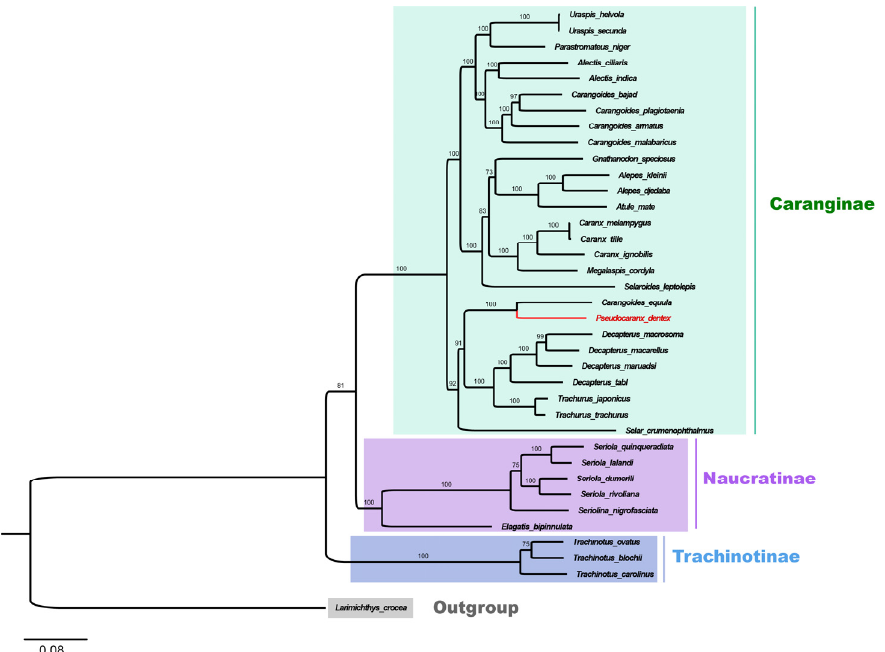
Figure 5. Phylogenetic tree of 36 species from the Carangidae family constructed by the maximum Likelihood method based on the concatenated sequences of 13 PCGs. L. crocea was set as an outgroup. The bootstrap support values were displayed on the branches. The species in red ( P. dentex ) was generated in the present study. Trachinotiae, Naucratinae, and Caranginae subfamilies were labeled in blue, purple, and green,